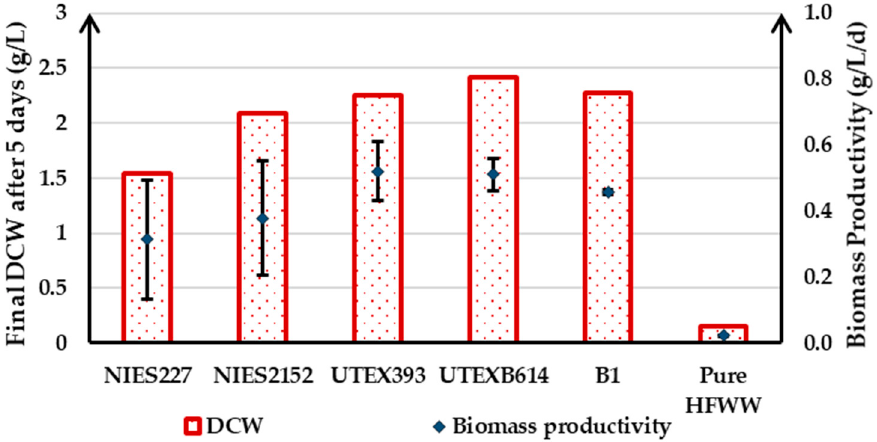
Figure 1. DCW (g/L) and biomass productivity (g/L/d) after 5 days of culture in pure HFWW in flasks for four strains (NIES227, NIES2152, UTEX393, and UTEXB614) and one consortium B1.